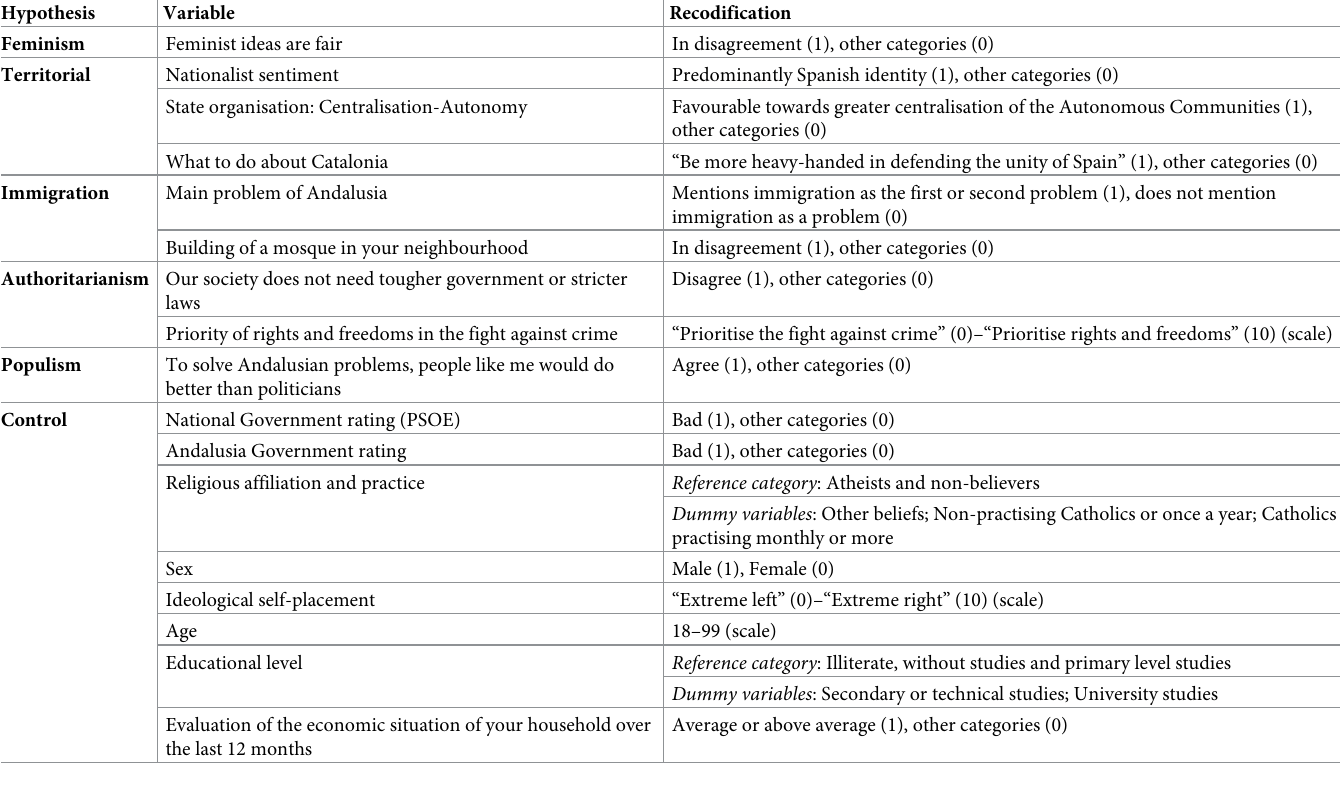
Table 1. Independent variables included in the regression